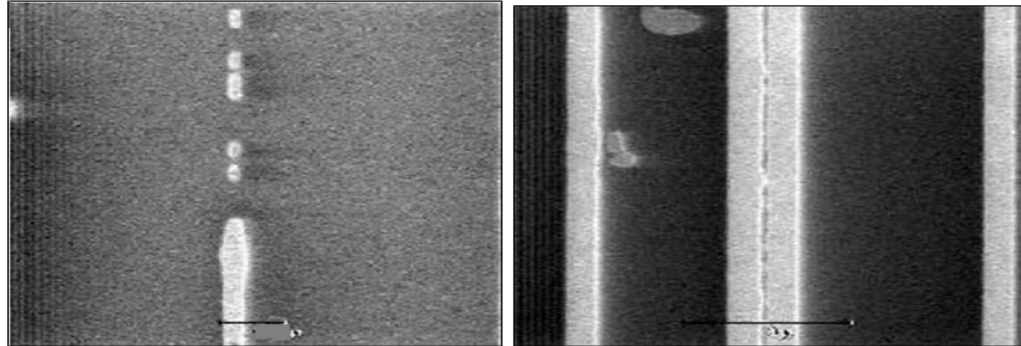
Figure 12. Two candidate defects which were shorts that spanned almost the entire chip.